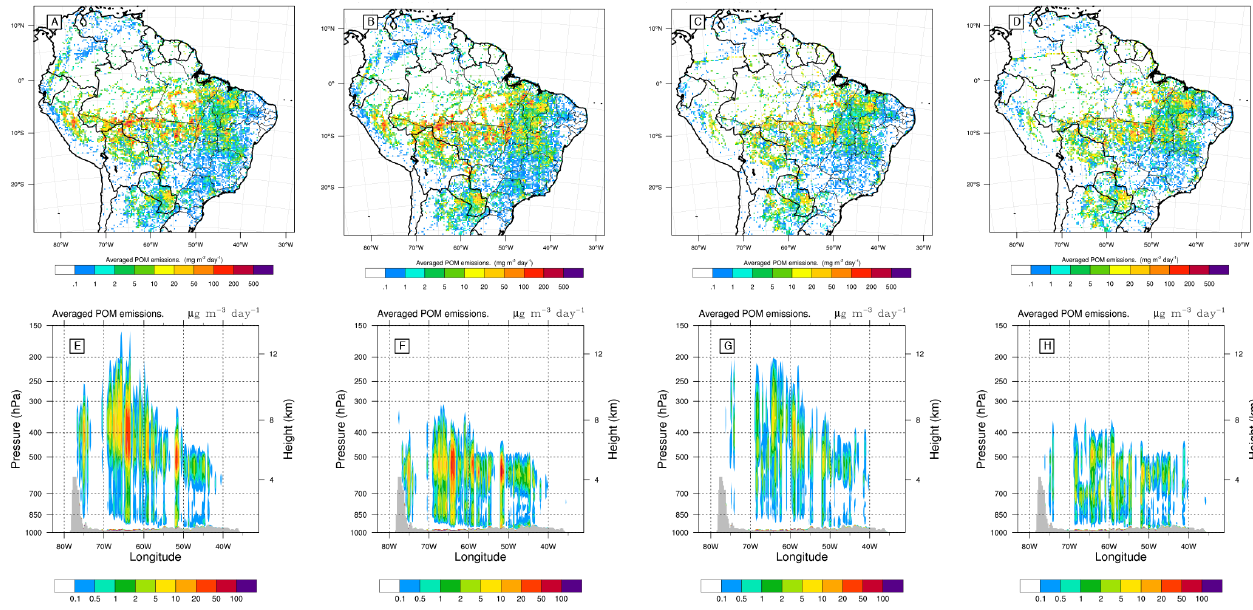
Figure 2. Emissions of organic aerosol (OA) over the course of the campaign. Panels (a–d) are maps of emissions, showing total emissions in the atmospheric column (mgm − 2 day − 1 ). Panels (e–h) are vertical profiles of emissions through a transect along 9 ◦ S (µgm − 3 day − 1 ). Panels (a) , (b) , (e) and (f) show averaged emissions over Phase I of the campaign (6–22 September 2012). (c) , (d) , (g) and (h) are averaged over Phase II (23–30 September). Panels (a) , (c) , (e) and (g) are for the traditional 3BEM emissions. Panels (b) , (d) , (f) and (h) are for the modified emissions, using smaller fire size and burned area depending on vegetation type as described in Table 2. Table 6. Table of mean, spatial standard deviation and centred Pearson’s product-moment correlation coefficient; comparing AOD at 550nm from the two WRF-Chem emissions scenarios with the combined MODIS Terra and Aqua satellite data. Data used same as to plot Fig. 5. Data set Phase I Phase II Mean Standard Correlation Mean Standard Correlation deviation coefficient deviation